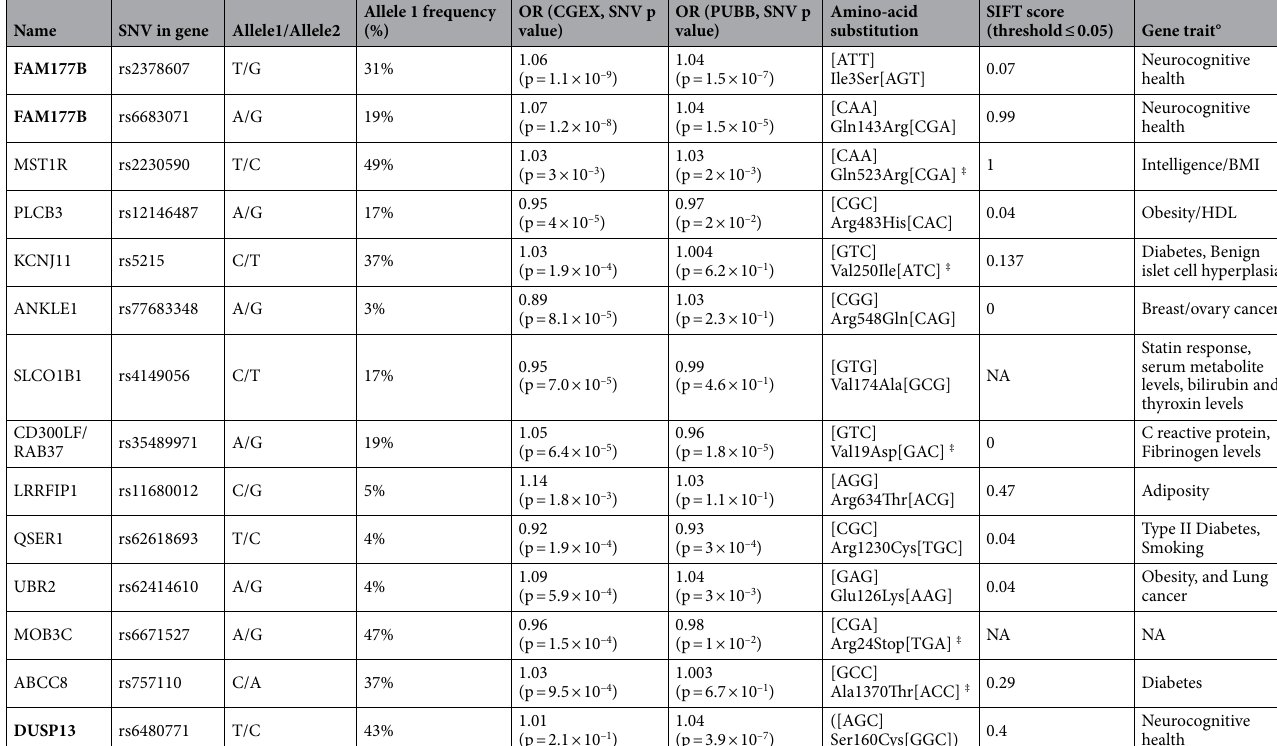
Table 2. Top enriched GBA genes previously unreported CAD associations. Genes in bold with p values less than the Bonferroni-corrected significance threshold in CGEX (CARDIoGRAM) or PUBB (Pan UK Biobank) study (p ≤ 3 × 10 –6 ). SIFT score: Sorting Intolerant from Tolerant score. A score ranges from 0–1, and score ≤ 0.05 is suggestive to functional consequence from protein alteration based on amino acid sequence change. HDL high density lipoprotein, BMI body mass index, NA not available, OR odds ratio for coronary artery disease. ‡ Negative strand. °Gene trait: Clinical phenotypes (maximum 2) obtained using the GWAS catalog (https:// www. ebi. ac. uk/ gwas/ genes), the Ensembl genome database (https:// www. ensem bl. org), the National Center for Biotechnology ClinVar web-based database (https:// www. ncbi. nlm. nih. gov/ clinv ar/ varia tion/), and through pubmed search (https:// pubmed. ncbi. nlm. nih.